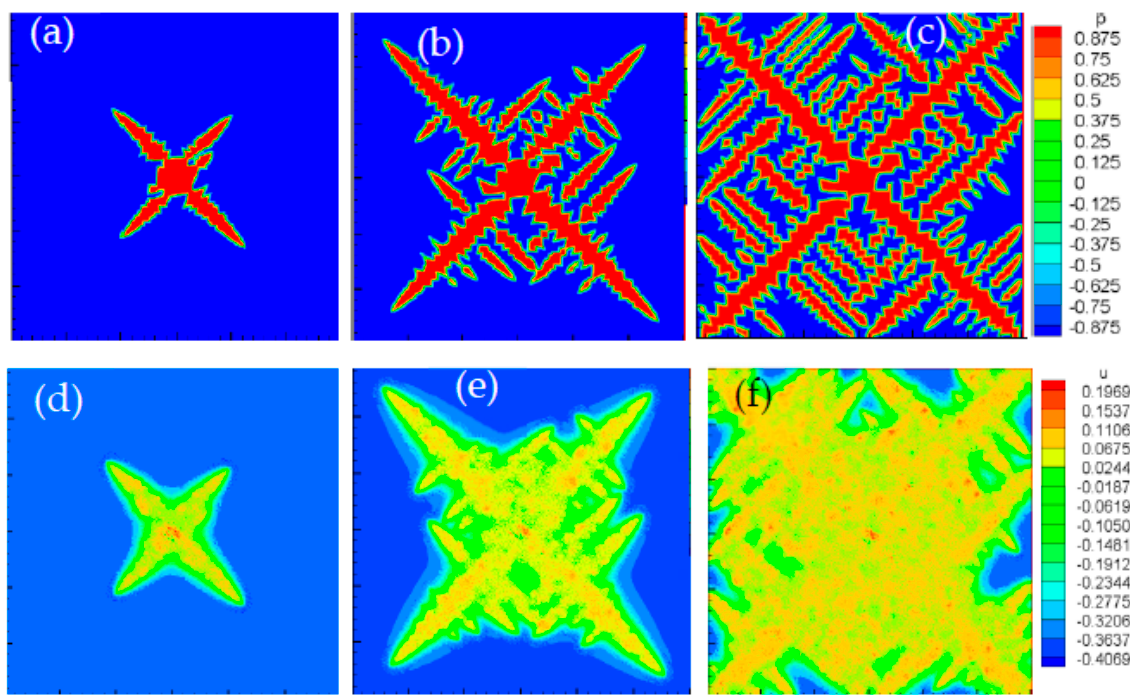
Figure 9. γ = 0.15, ∆ = − 0.55, ( a , b , c ) are the phase fields of the silicon crystal at t = 3000 ∆ t, t = 6000 ∆ t, and t = 9000 ∆ t, respectively; ( d , e , f ) are the temperature fields of the silicon crystal at t = 3000 ∆ t, t = 6000 ∆ t, and t = 9000 ∆ t, respectively.